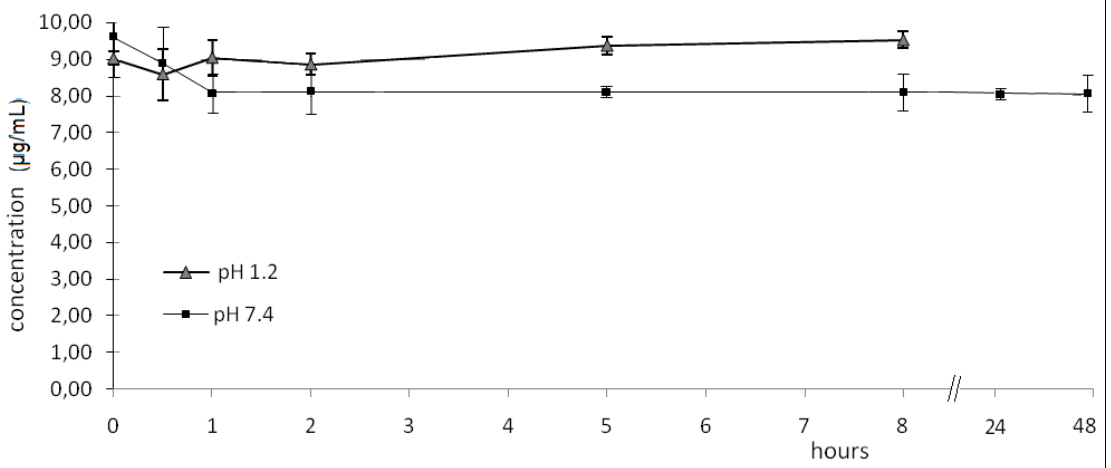
Figure 1. Hydrolysed of lactam derivatives (µg/mL) in buffer pH 1.2 and 7.4 (data are represented as mean ±S.E.M., n = 6, P <